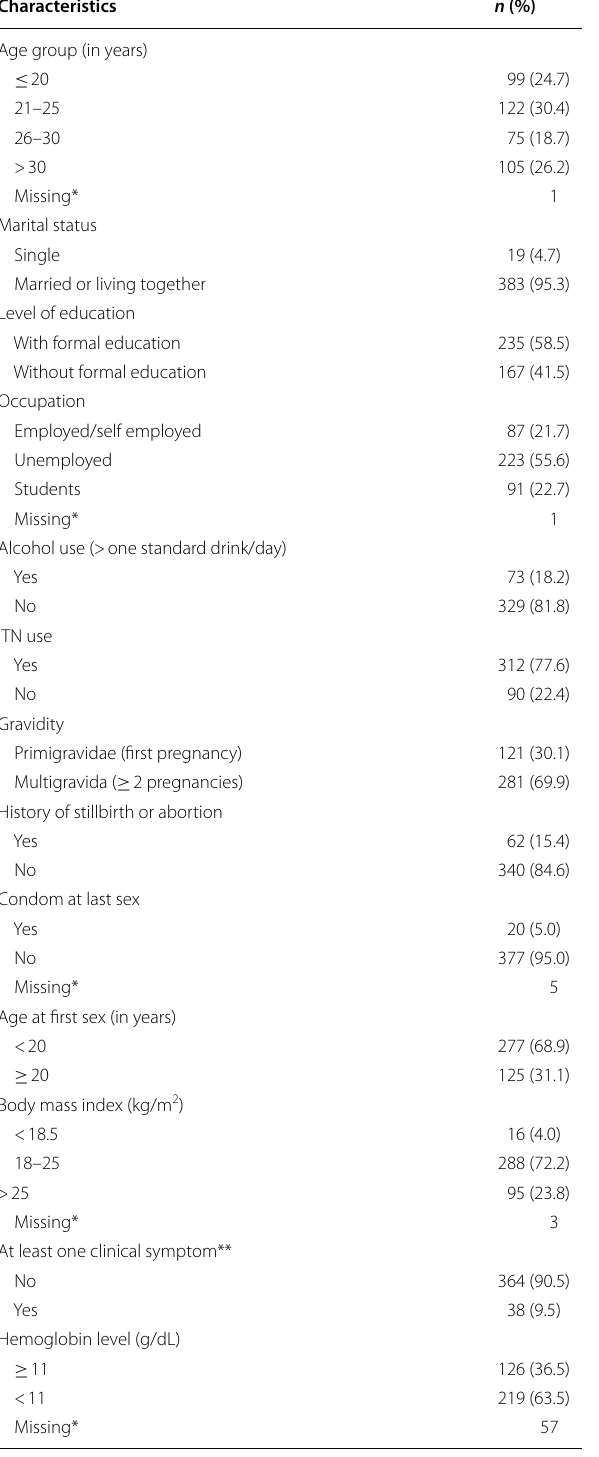
Table 1 Baseline characteristics of pregnant women at their